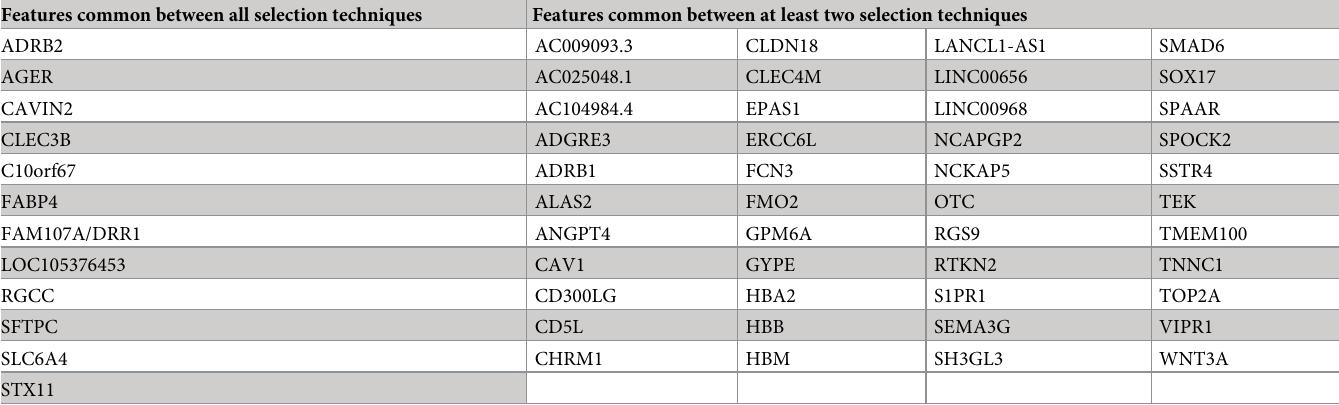
Table 2. List of features common between all selection techniques or common between at least two selection techniques. Features common between all selection techniques